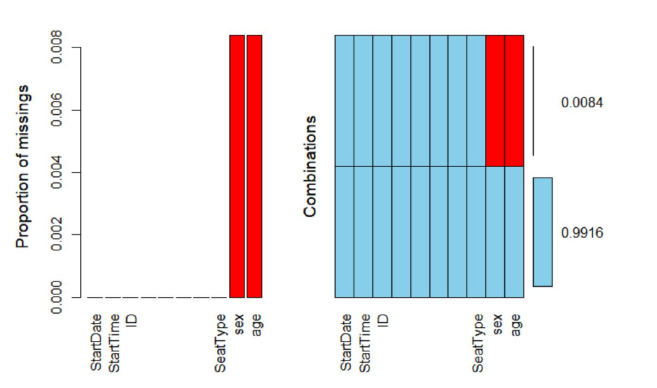
Figure 2. Variable outlier detection chart. Only the variables Sex and Age have missing values. The variables Sex and Age have missing values, and there is a synergy between them, they all have 837,877 missing